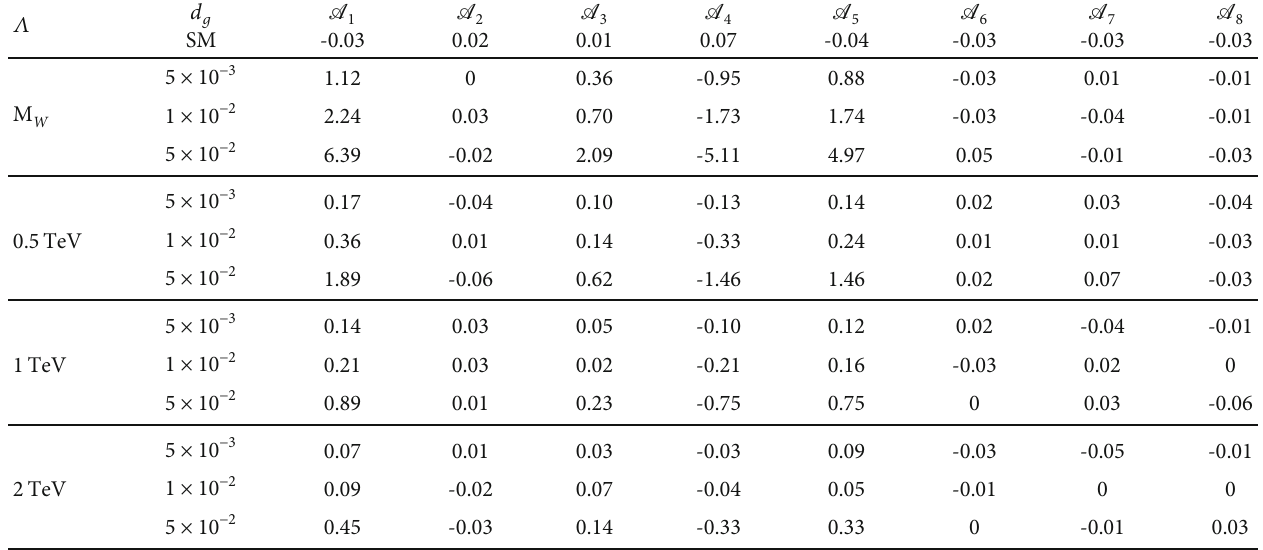
Table 3: Integrated asymmetries (in %) at LO for observables for distinct choices of d 3 × 10 − 4